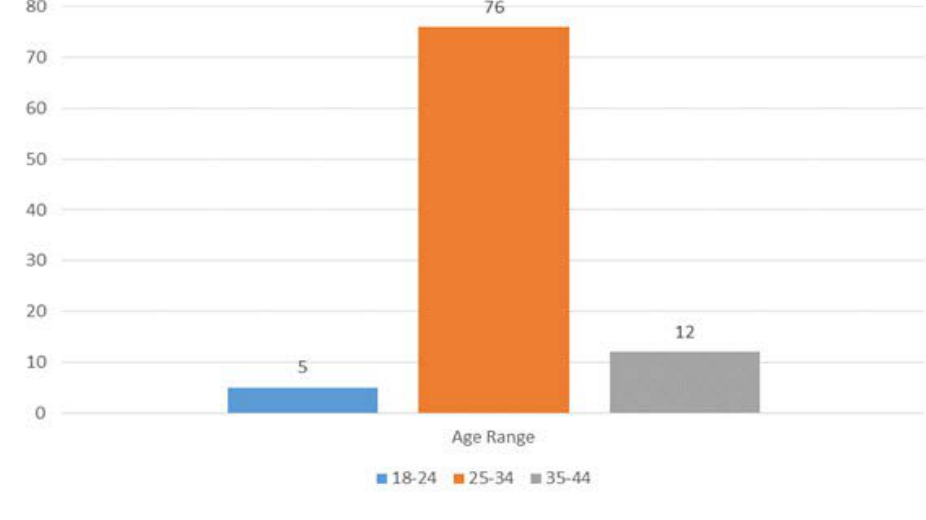
Figure 2 . Online learners’ age